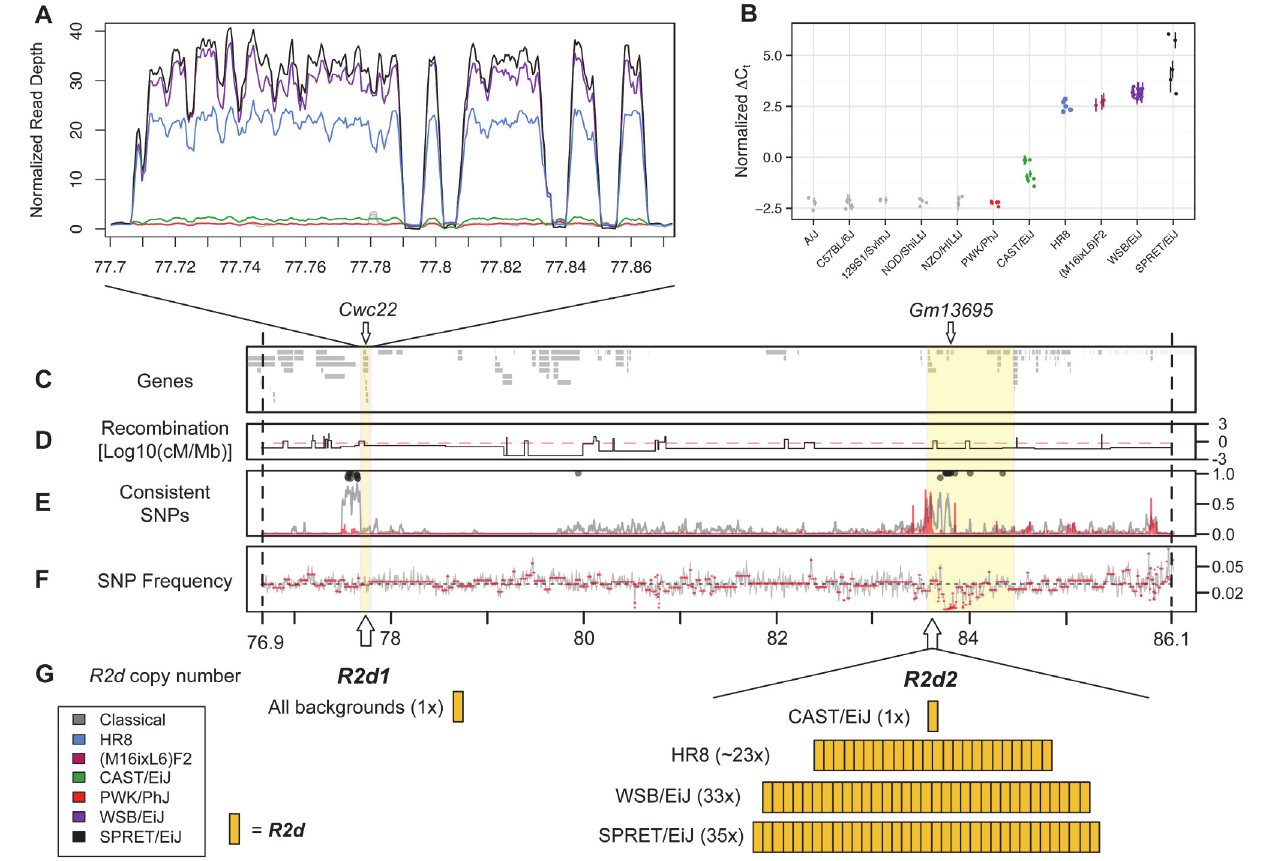
Figure 2. A large copy number gain is present in strains with maternal TRD. A) Read depth in 100 bp windows, normalized by the genome-wide mean read depth for each strain, for R2d1 , a 158 kb region within the 9.3 Mb candidate interval defined in Fig. 1. R2d1 includes a single (non-contiguous) copy of R2d . Strains are represented by the colors shown in the inset. Inbred strains included under the heading “ classical ” are A/J, 129S1/SvImJ, C57BL/6JN, NOD/ ShiLtJ and NZO/HILtJ. The four large gaps represent LINEs that were inserted in the unique copy found in the reference genome after initial duplication. B) R2d copy number estimated by TaqMan assays for Cwc22 . Normalized cycle threshold ( Δ C t ; see Methods) is proportional to absolute copy number on the log scale. Strains are colored as in panel A. The (M16ixL6)F2 samples shown are known to be homozygous for the M16i allele based on genotypes from the MegaMUGA array. C-F) The yellow boxes highlight the 158 kb region depicted in panel A ( R2d1 ) and the 900 kb R2d2 locus mapping interval. Vertical dashed lines indicate the boundaries of the 9.3 Mb candidate interval. C) Locations of Ensembl genes in the NCBI/37 reference genome within the interval. The locations of the Cwc22 gene and of seven Cwc22 pseudogenes ( Gm13695 ), are shown. D) Recombination frequency based on Liu et al. (2014), normalized by physical distance (Mb) and log10-transformed. The red line indicates the mean recombination frequency for Chr 2. E) Frequency distribution measured in 1 kb windows of SNPs with shared alleles among the three strains with TRD (WSB/EiJ, SPRET/EiJ and HR8; gray line), and with alleles perfectly consistent between strains with TRD and strains without TRD (A/J, 129S1/SvImJ, C57BL/6JN, NOD/ShiLtJ, NZO/HILt, CAST/EiJ and PWK/PhJ; red line). Lines are smoothed. Black circles indicate windows in which the strains with TRD share an allele for at least 90% of SNPs. F) Frequency distribution of reported SNPs in the candidate interval. G) The location and the number of copies of R2d that are present in R2d1 and R2d2 .